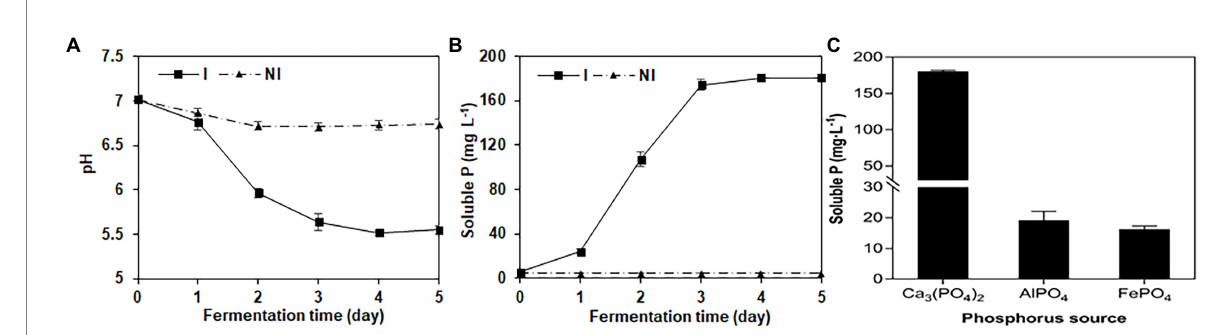
FIGURE 2 Changes of pH value (A) and soluble P (B) in National Botanical Research Institute’s Phosphate medium (NBRIP) liquid broths with the extension of the fermentation time, and soluble P in the NBRIP liquid broths supplemented with the various phosphorus sources (C) after the inoculation with